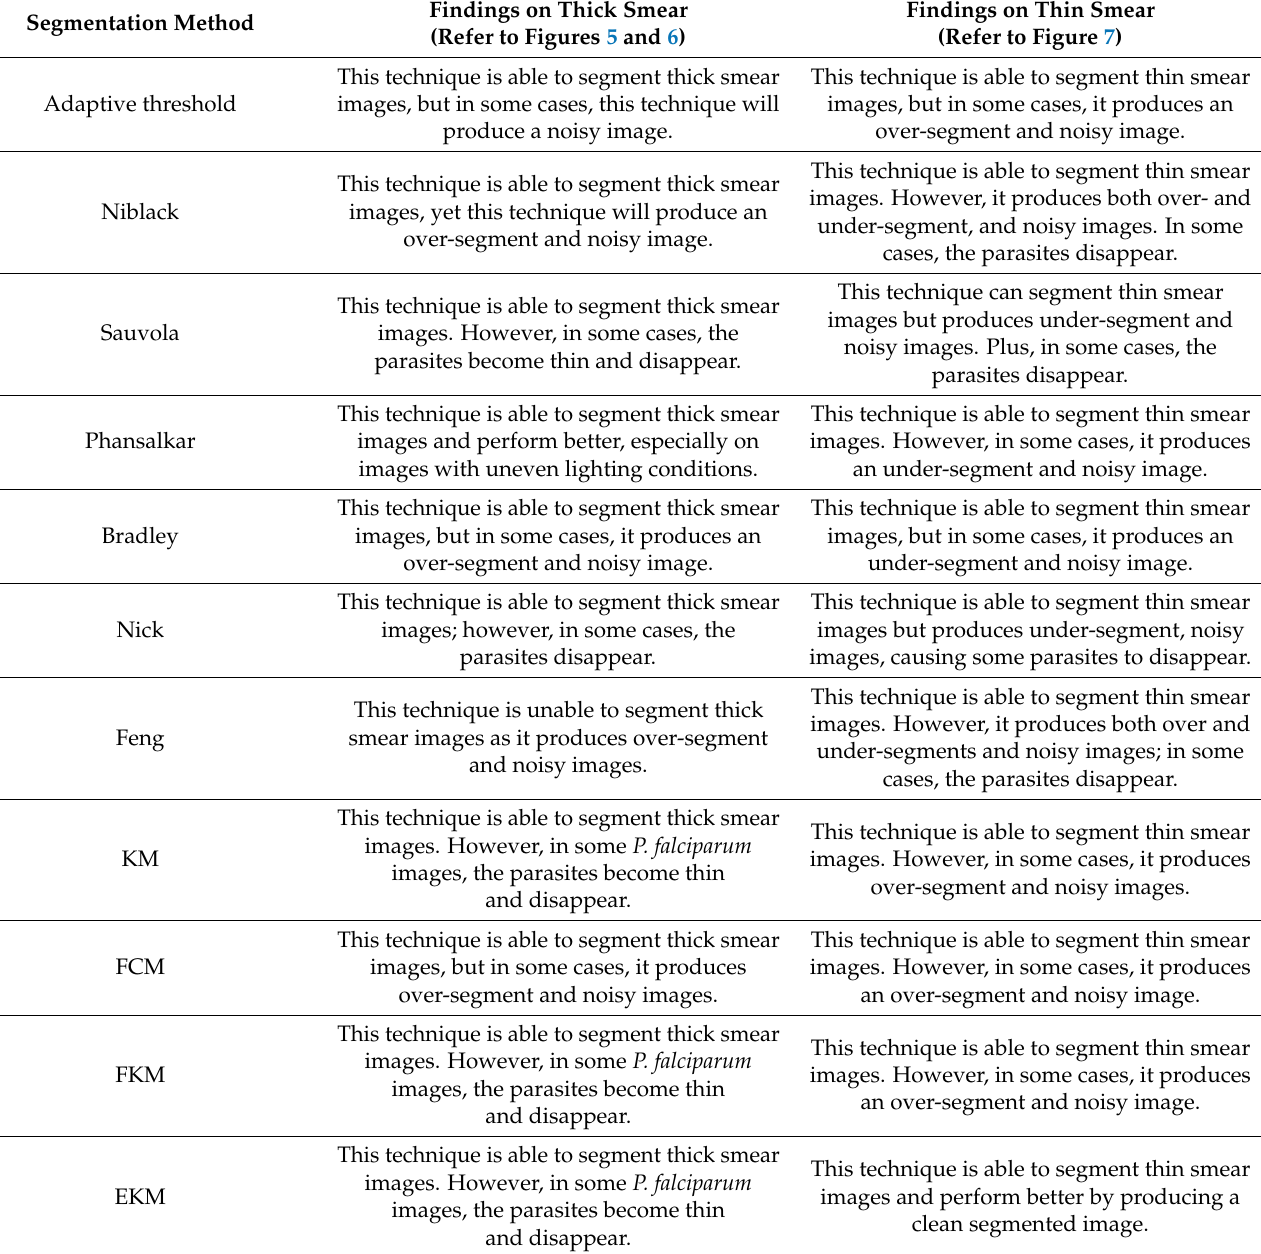
Table 3. Findings of investigated segmentation techniques on thick and thin blood smear